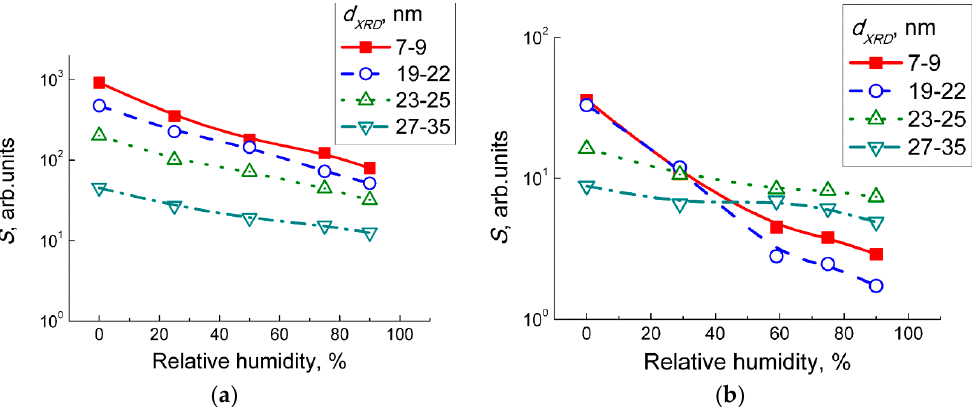
Figure 7. Sensor signals responses of WO 3 with different grain size to 1 ppm NO 2 ( a ) and 5 ppm NO ( b ) in relation to temperature.